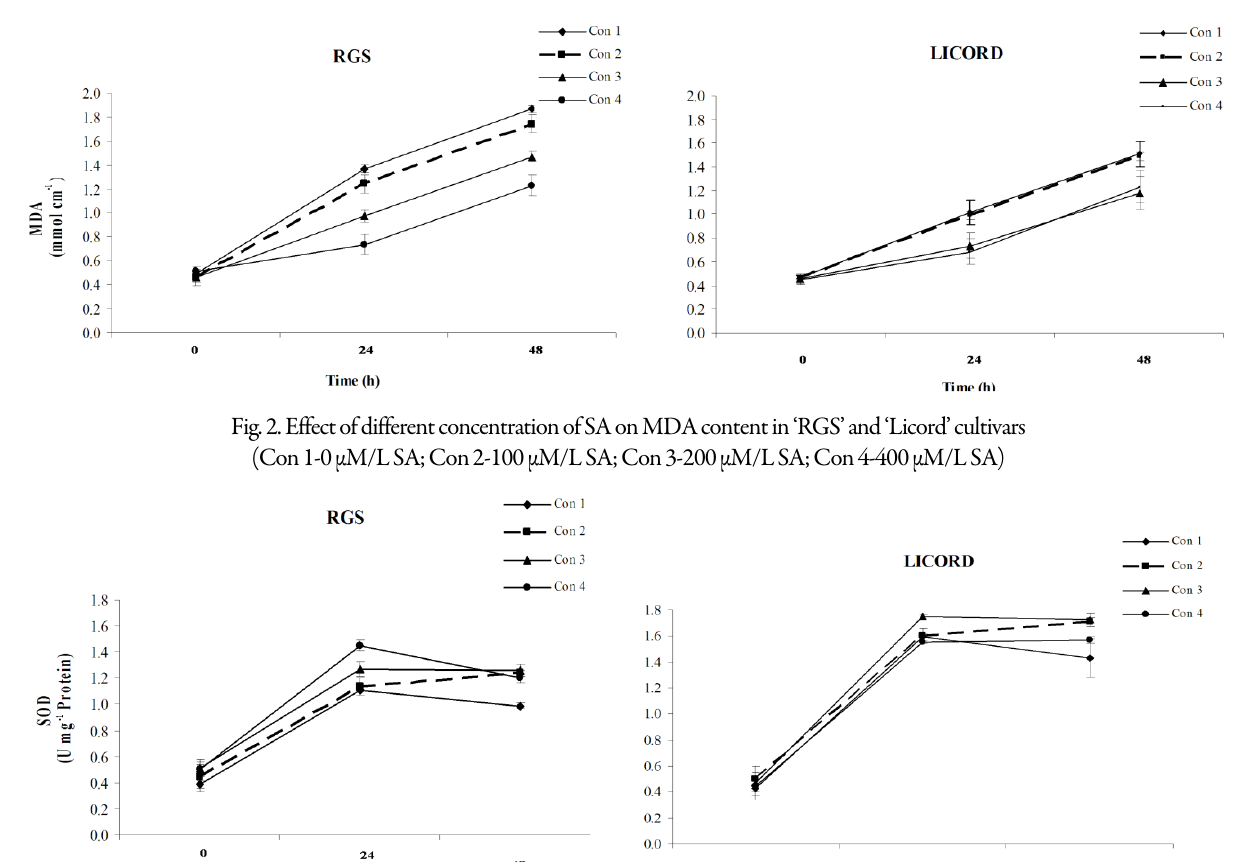
Fig. 1. Effect of different concentration of SA on total Chl content in ‘RGS’ and ‘Licord’ cultivars (Con 1-0 µM/L SA; Con 2-100 µM/L SA; Con 3-200 µM/L SA; Con 4-400 µM/L SA)